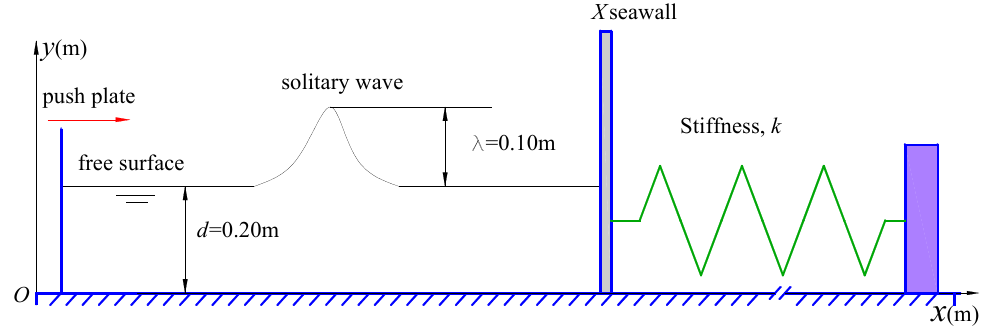
Figure 13. Schematic sketch of the movable seawall model.